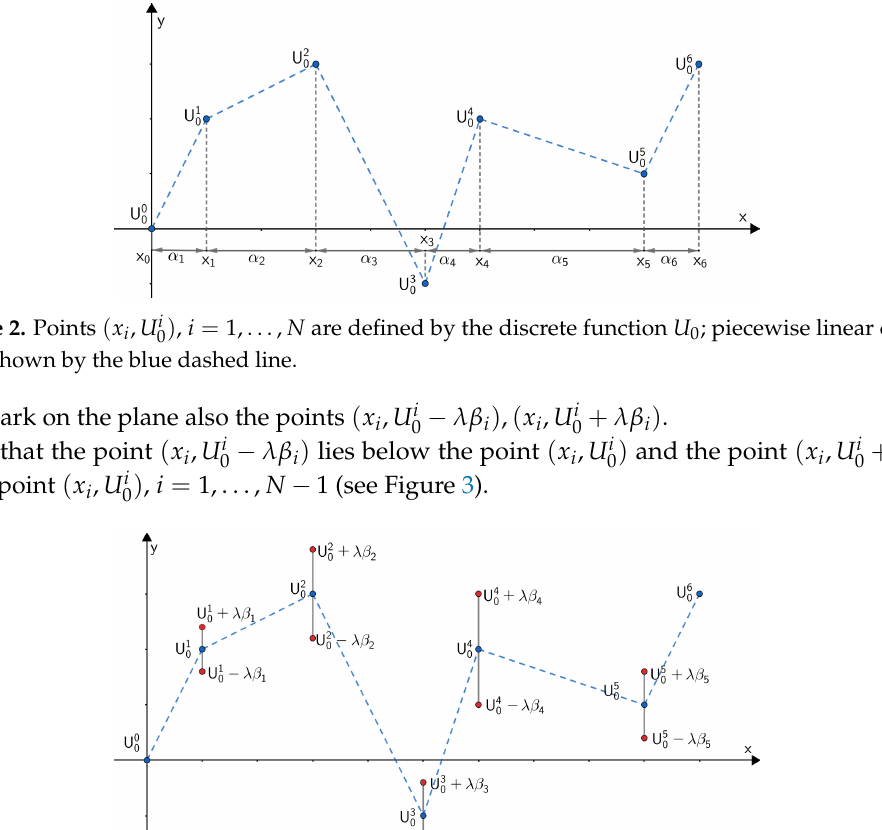
Figure 3. Curve C 0 (blue dashed line) and vertical λβ i neighborhoods of the vertices ( x i , U i